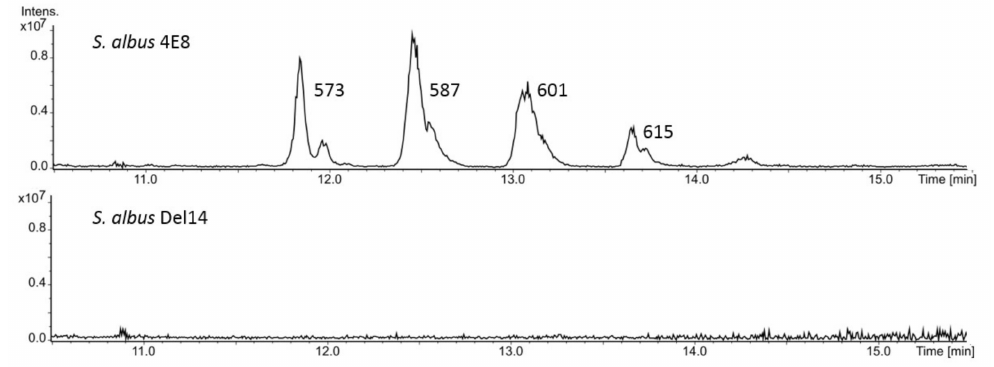
Figure 1. HPLC-MS analysis of dudomycin production by S. albus Del14 strain harboring the BAC (bacterial artificial chromosomes) 4E8. The strain S. albus Del14 without the BAC was used as a control. The extracted base peak chromatograms 573-574 Da, 587-588 Da, 601-602 Da, 615-616 Da are